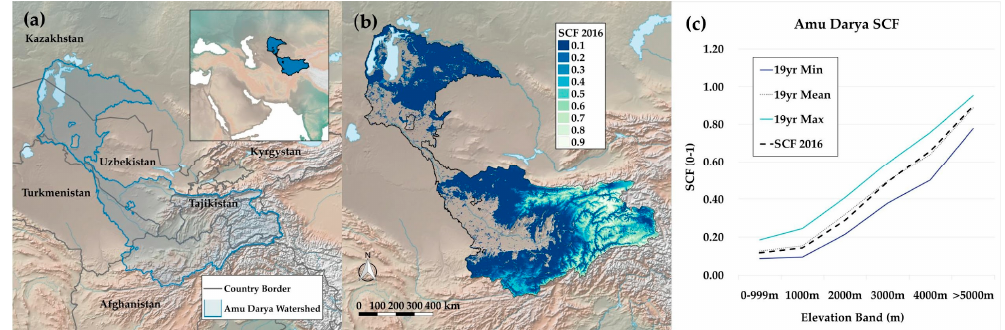
Figure 6. ( a ) The Amu Darya Basin (ADB) transboundary map with country boundaries. ( b ) The WY2016 snow cover frequency (SCF) map of the ADB at 500 m resolution generated from the SnowCloudMetrics portal. ( c ) The 19-year maximum, 19-year minimum, and 19-year mean SCF values for the ADB, spatially averaged and binned by elevation band plotted with the WY2016 SCF dataset. SDD images for the ADB were computed for the same 2001–2019 time period. Maximum,